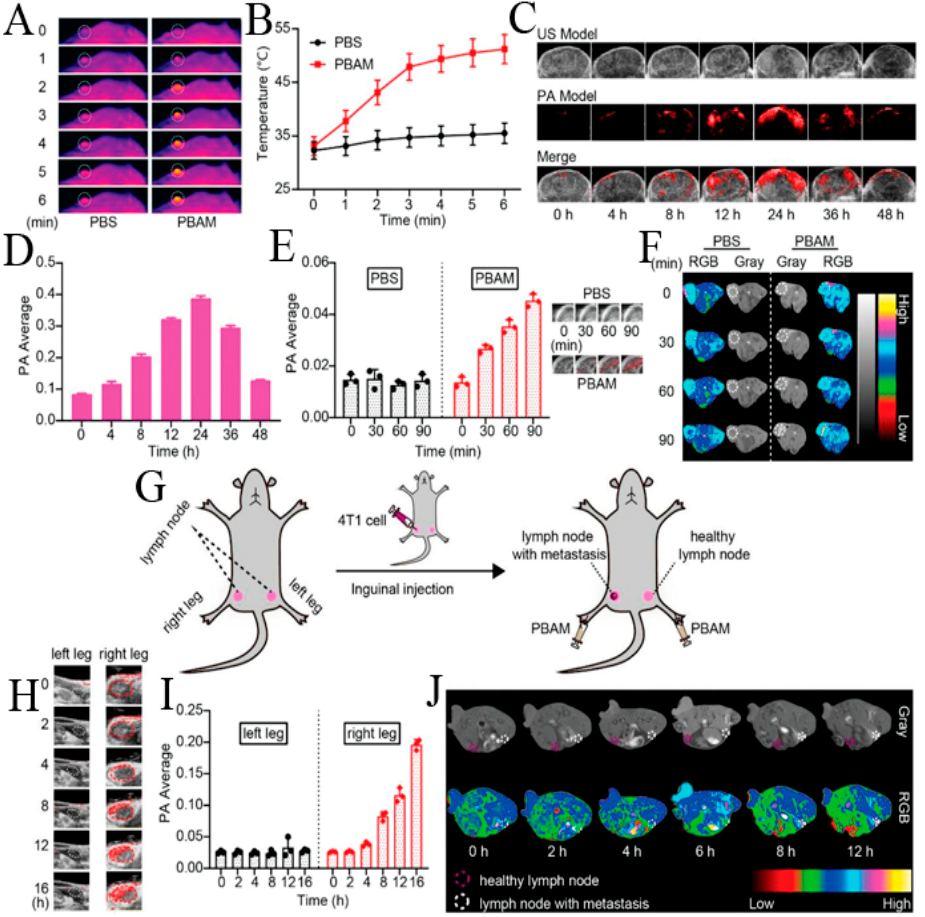
Figure 10. ( A ) Infrared thermal imaging and ( B ) tumor temperature of 4T1 ‐ tumor model mice after intravenous injection with PBAM under 808 nm laser (1 W cm − 2 ). White circle: tumor tissue. ( C ) Tumor PAI and ( D ) Corresponding PAI signal intensity of 4T1 ‐ tumor model mice after intravenous injection with PBAM. ( E ) Tumor PA signal intensity and corresponding PAI of 4T1 ‐ tumor model mice after subcutaneous injection with PBAM. ( F ) MRI of 4T1 ‐ tumor model mice after subcutaneous injection with PBAM. White circle: tumor tissue. ( G ) Schematic of lymphatic metastasis tumor model. ( H ) PAI of lymph nodes with or without metastasis at different time points after injection with PBAM. White circle: the lymph nodes in left leg. Red circle: the lymph nodes in right leg. ( I ) Corresponding PAI signal intensity of lymph nodes with or without metastasis. ( J ) MRI of lymph nodes with or without metastasis at different time points after injection with PBAM. Reprinted with permission from Ref. [20]. Copyright 2020, WILEY ‐ VCH Verlag GmbH & Co. KGaA, Weinheim.